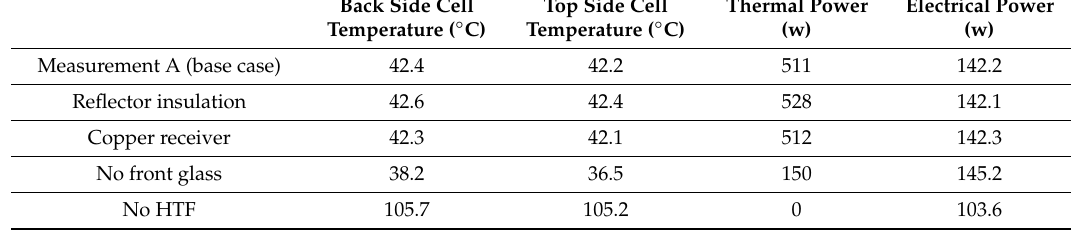
Table 5. Performance of the di ff erent collector variations studied (T amb = 18.6 ◦ C, T m = 35.1 ◦ C).